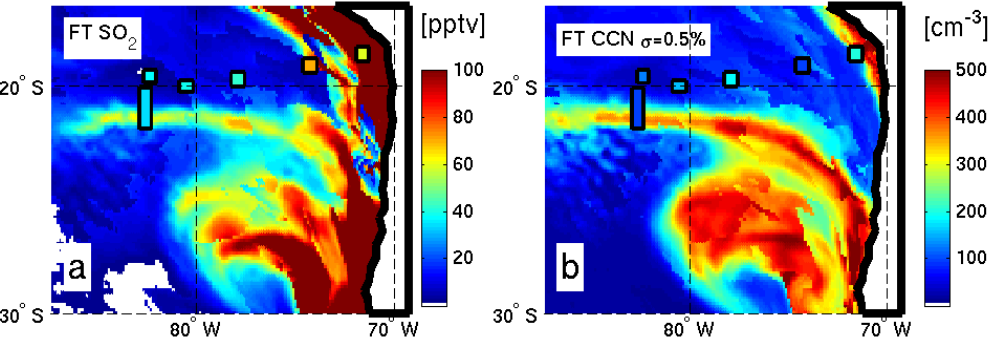
Fig. 7. Contours of model (a) SO 2 and (b) CCN at σ = 0 . 5% in the model level above the inversion on 17 October at 15:00UTC, 24h before the VOCALS C-130 RF02 flight (13:00–21:00UTC 18 October) to correct for model and satellite observations time offset of N d (Figs. 2 and 6). Superimposed rectangles show above-cloud flight leg mean data SO 2 measurements and CCN when measured for σ = 0 .